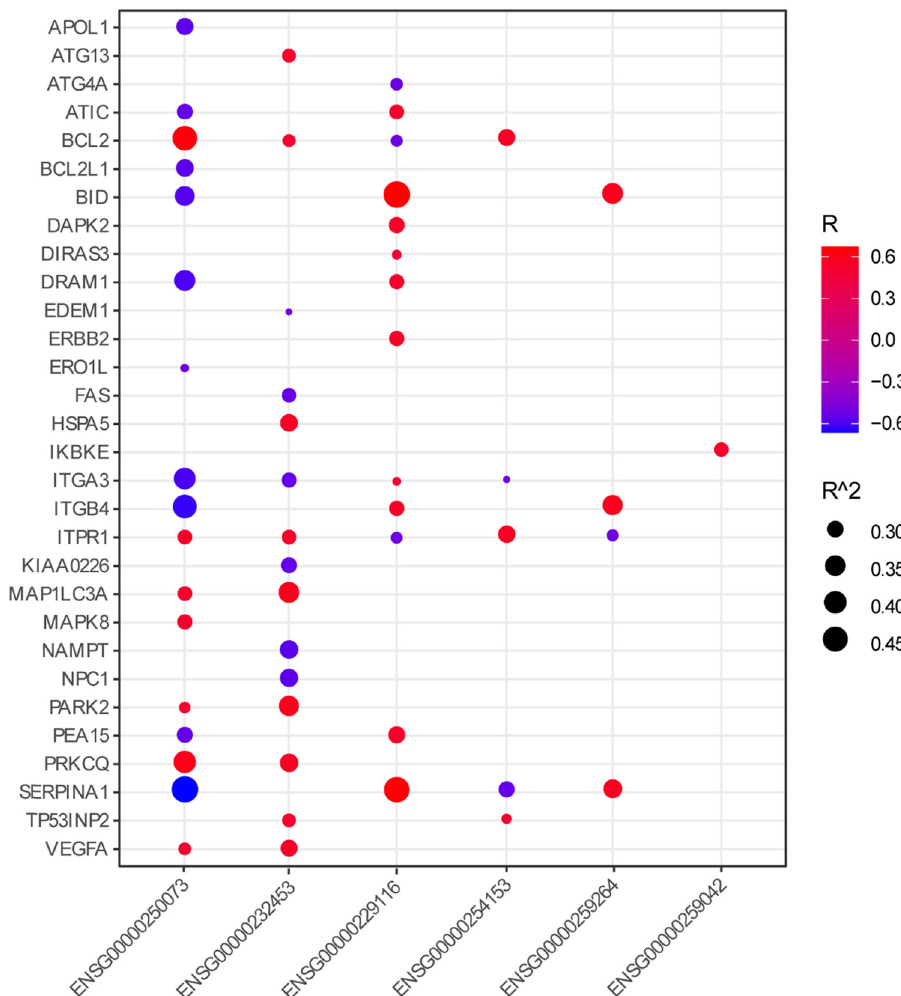
Figure 4: Correlation of the selected six lncRNAs with